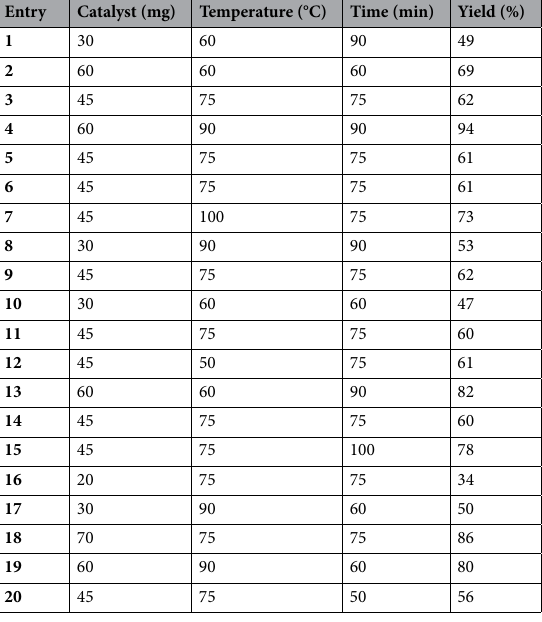
Table 3. Three-level full factorial design. Benzaldehyde, ethyl acetoacetate and urea (molar ratio: 1:1:1.2).